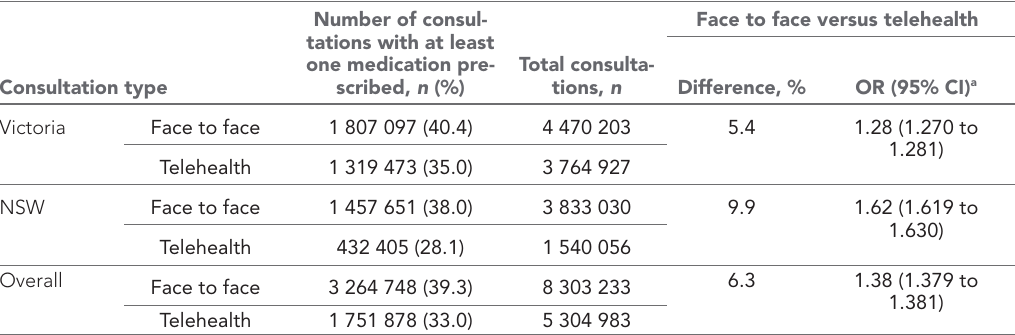
Table 2 Difference in medication prescribing between face- to- face and telehealth